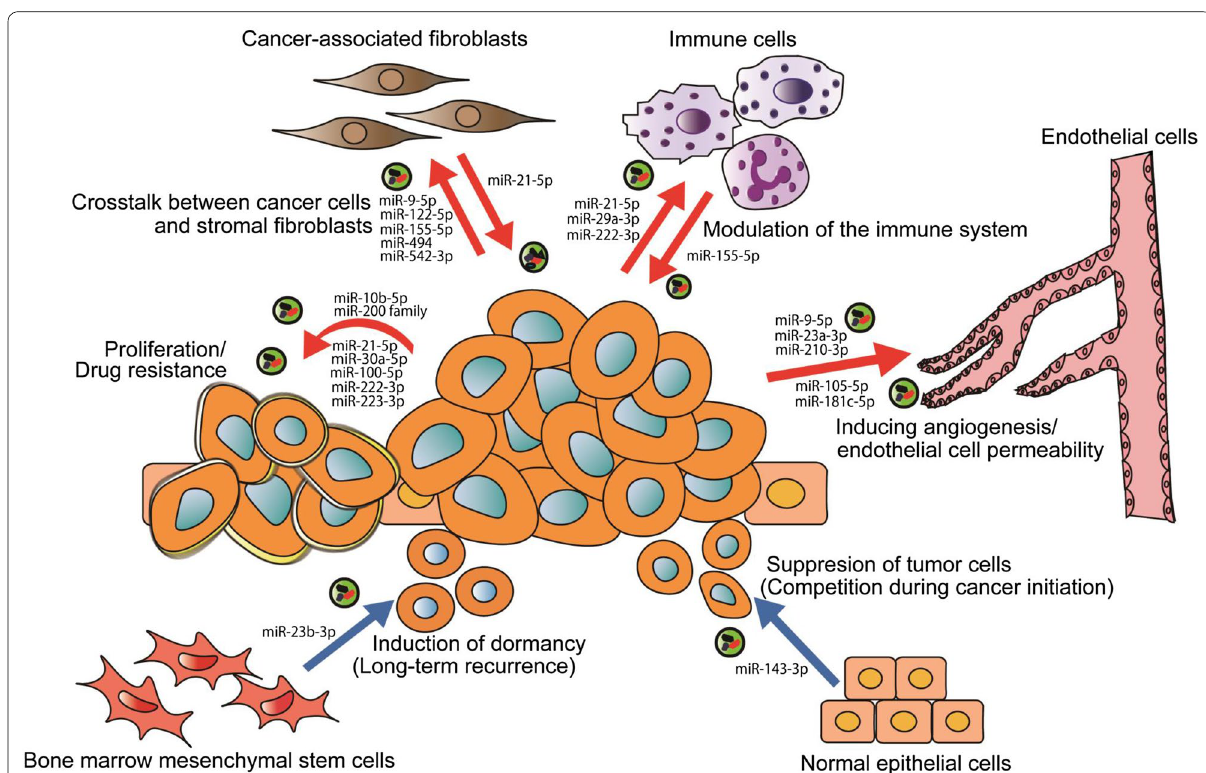
Fig. 2 Role of miRNAs in EVs in the cancer microenvironment. Through the transfer of miRNAs, EVs mainly promote tumorigenesis. Tumor-derived EVs can activate endothelial cells to promote angiogenesis or vascular permeability. Tumor-derived EVs can convert fibroblasts into CAFs. In return, CAF-derived EVs can confer proliferation or drug resistance to tumor cells. Tumor-derived EVs can contribute to creating an immunosuppressive microenvironment by impairing the function of immune cells. In another aspect of the immune system, tumor-derived EVs can mobilize TAMs to promote cancer progression. Moreover, tumor-derived EVs can provide drug resistance or proliferation to surrounding other tumor cells. In contrast, noncancerous cell-derived EVs also participate in the tumor microenvironment. EVs derived from MSCs contribute to long-term metastasis by inducing a dormant state in cancer cells. EVs derived from normal epithelial cells can suppress cancer